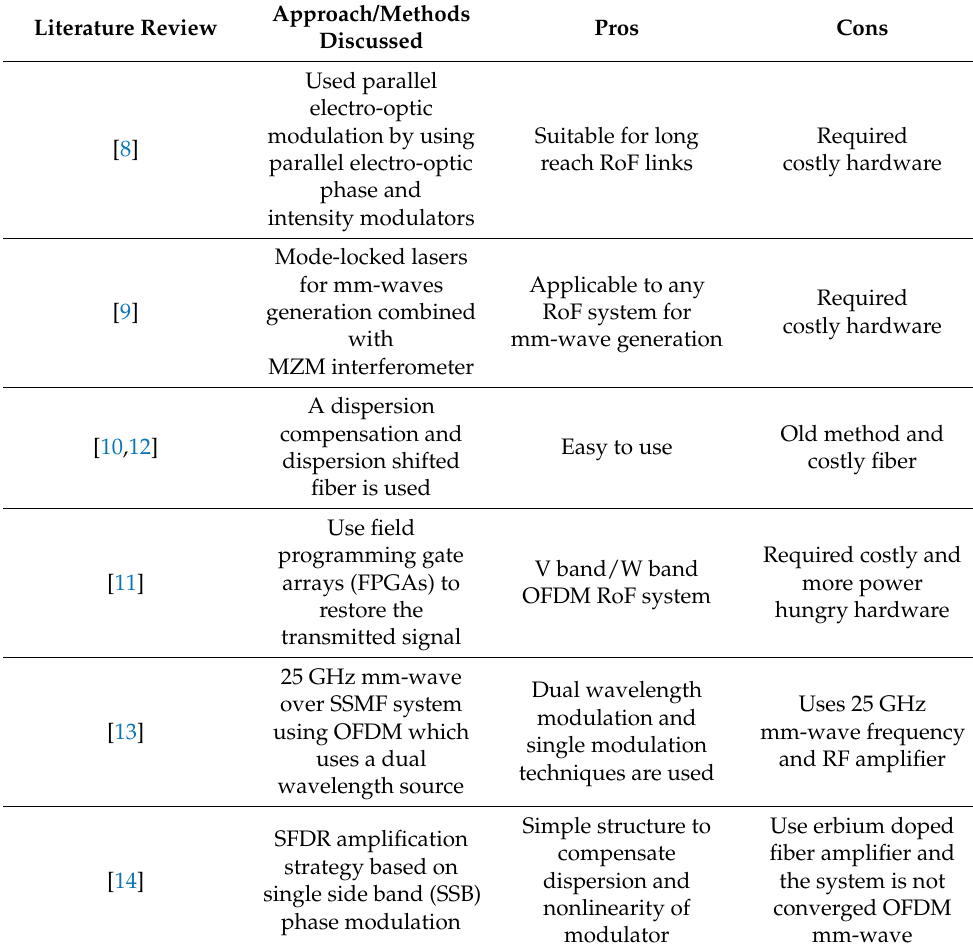
Table 1. Methods discussed in the literature review to compensate for the dispersion in converged mm-wave OFDM A-RoF